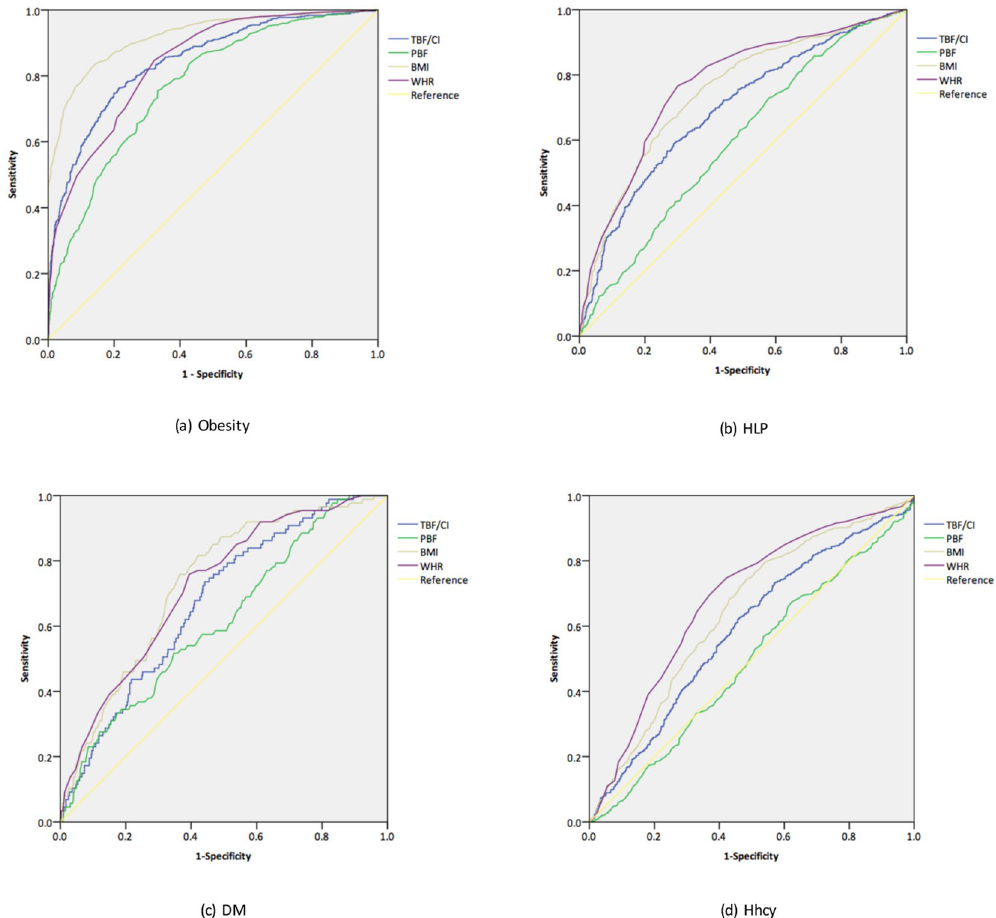
Figure 3. Receiver Operator Curves of different anthropometric indices as predictors of various metabolic diseases. TBF/CI: total body fat/conicity index; PBF: percentage body fat; BMI: body mass index; WHR: waist- hip